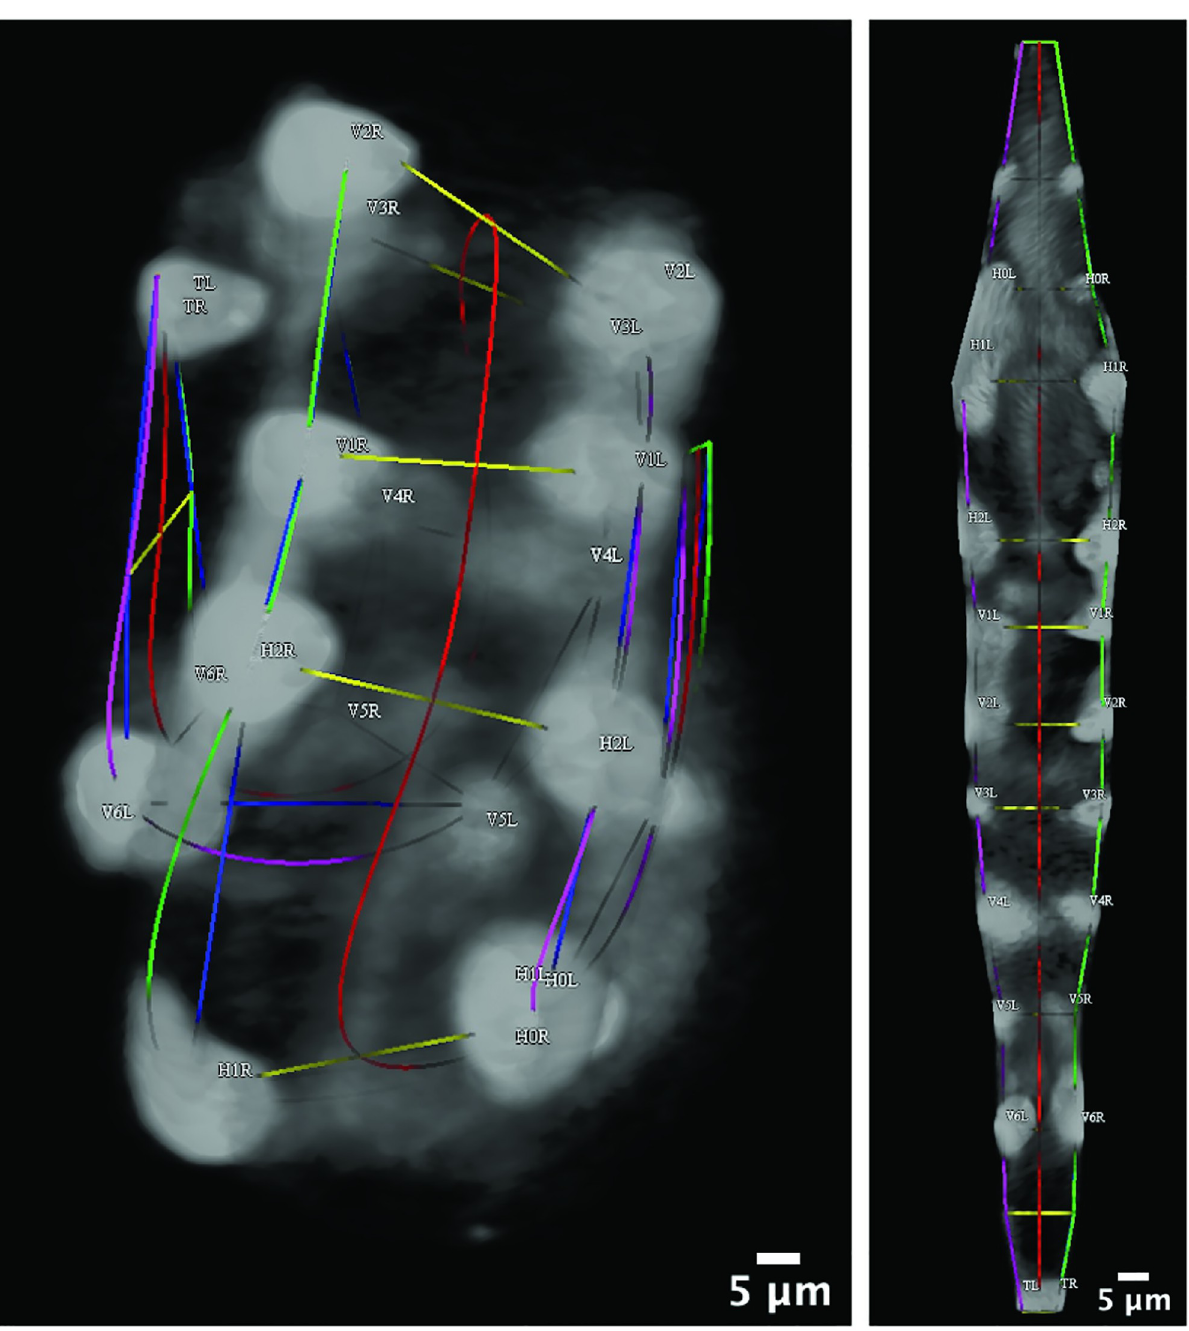
Fig 6. Rendered image volumes in the MIPAV GUI. The imaged twisted embryo (left) and imaged straightened embryo (right) rendered in Medical Image Processing, Analysis and Visualization (MIPAV) [25]. The fluorescent images are those depicted in Fig 1A. Trained users navigate the MIPAV GUI to identify seam cells based upon relative positioning and other salient features such as specks of fluorescence on the skin. Correct identification of all imaged nuclei reveals the coiled embryonic posture. Green (left), red (center), and purple (right) splines yield an approximation of the coiled embryo’s posture. Yellow lines connect seam cell nuclei laterally. The splines are used with the image volume to sweep planes orthogonal to the center spline, yielding the straightened embryo image.